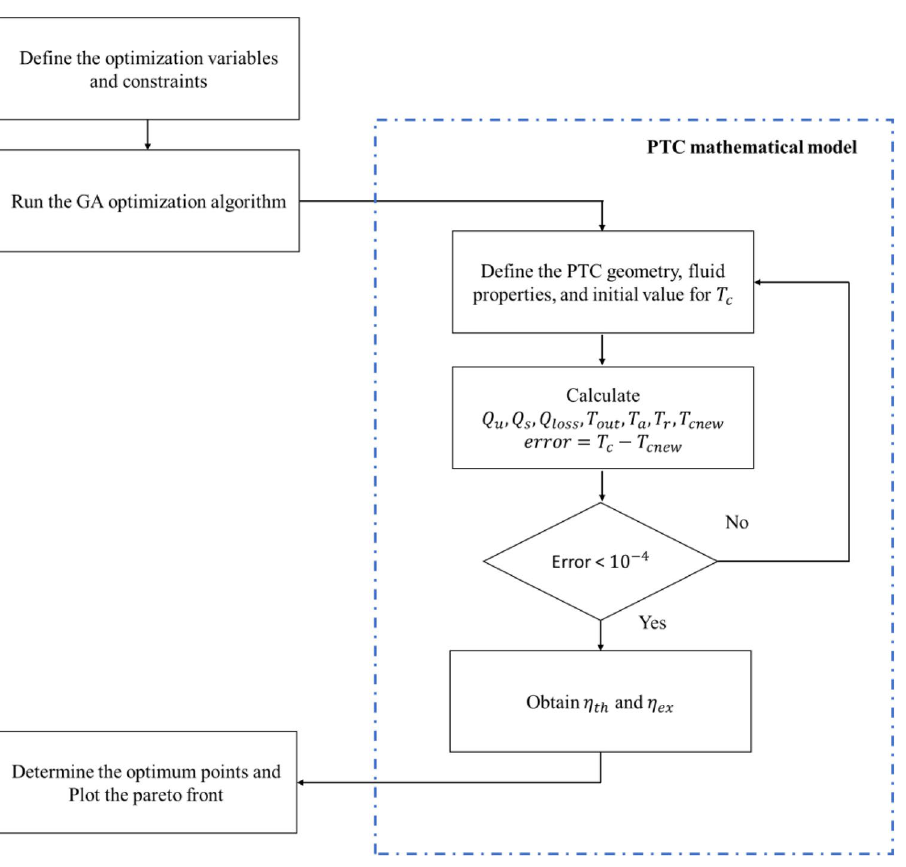
Figure 5. Flowchart for the optimization